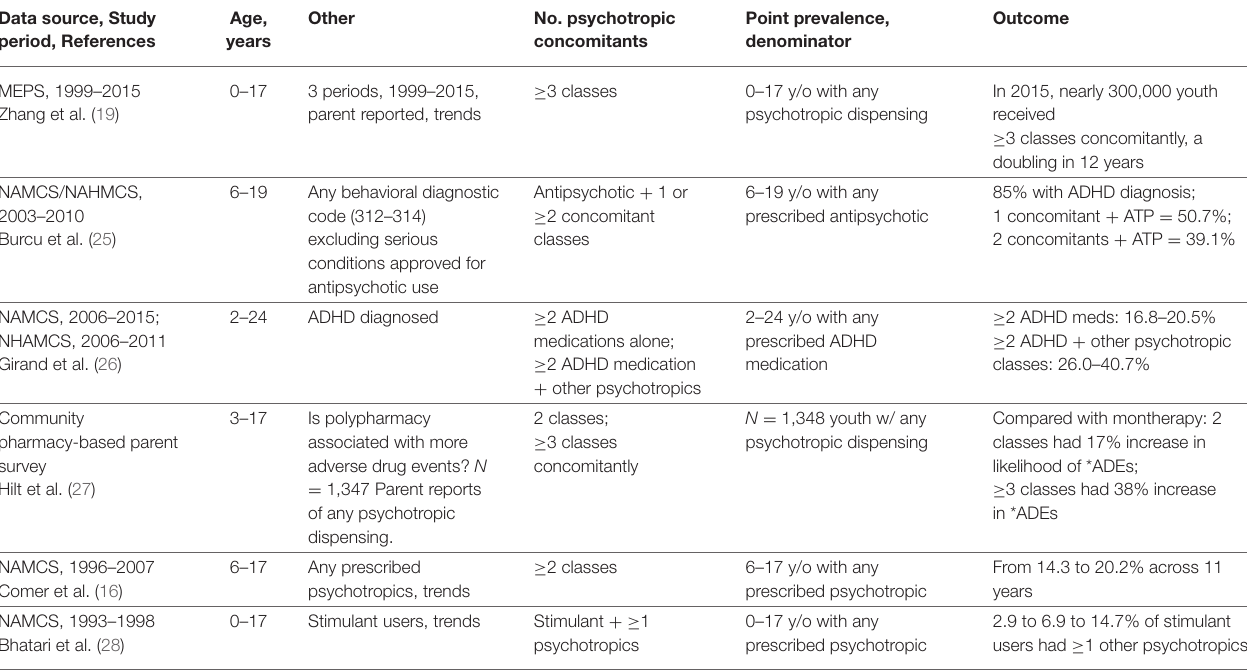
TABLE 1 | Federal and other population-based surveys on pediatric psychotropic